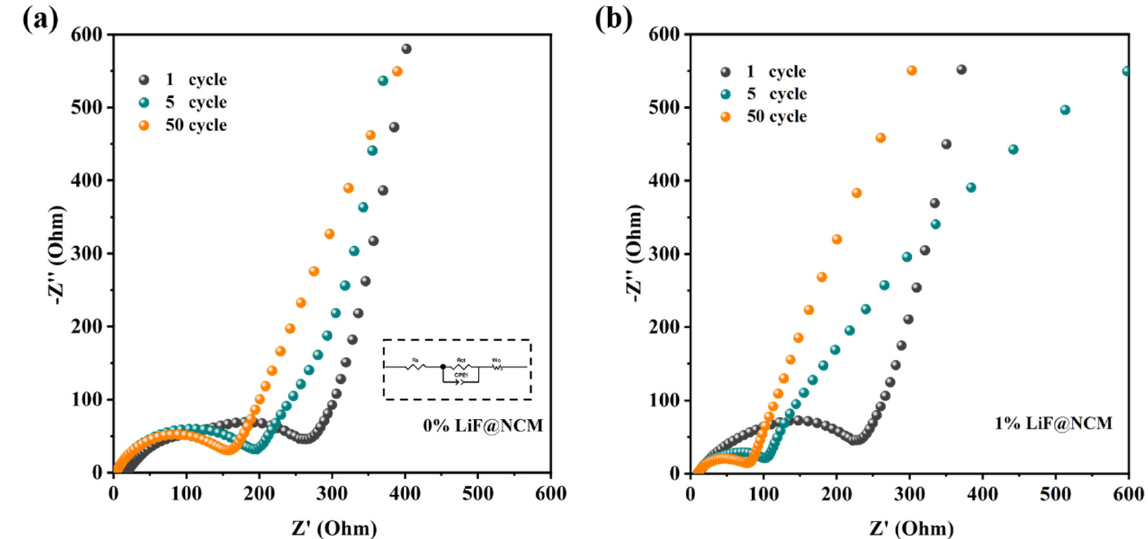
Figure 9. Nyquist plots of ( a ) 0%LiF@NCM and ( b ) 1%LiF@NCM electrodes after the 1st, 5th and 50th cycles (Inset shows the used equivalent circuit). Table 1. The performances of our work compared to some previous reports.